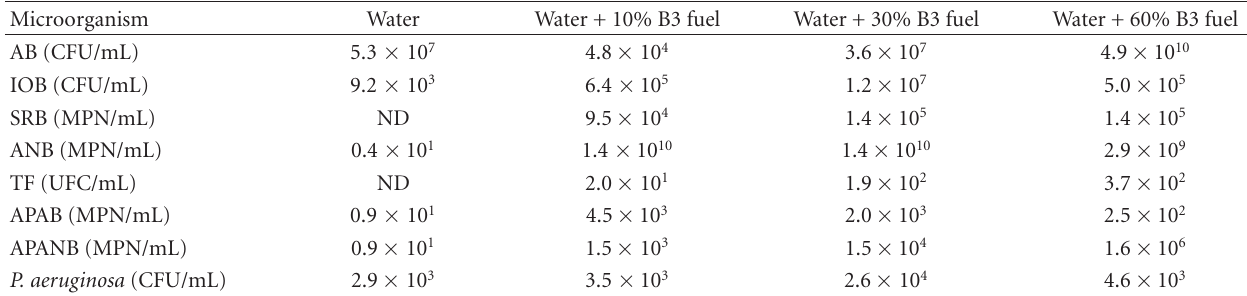
Table 1: Planktonic microorganisms in the fluids used in the